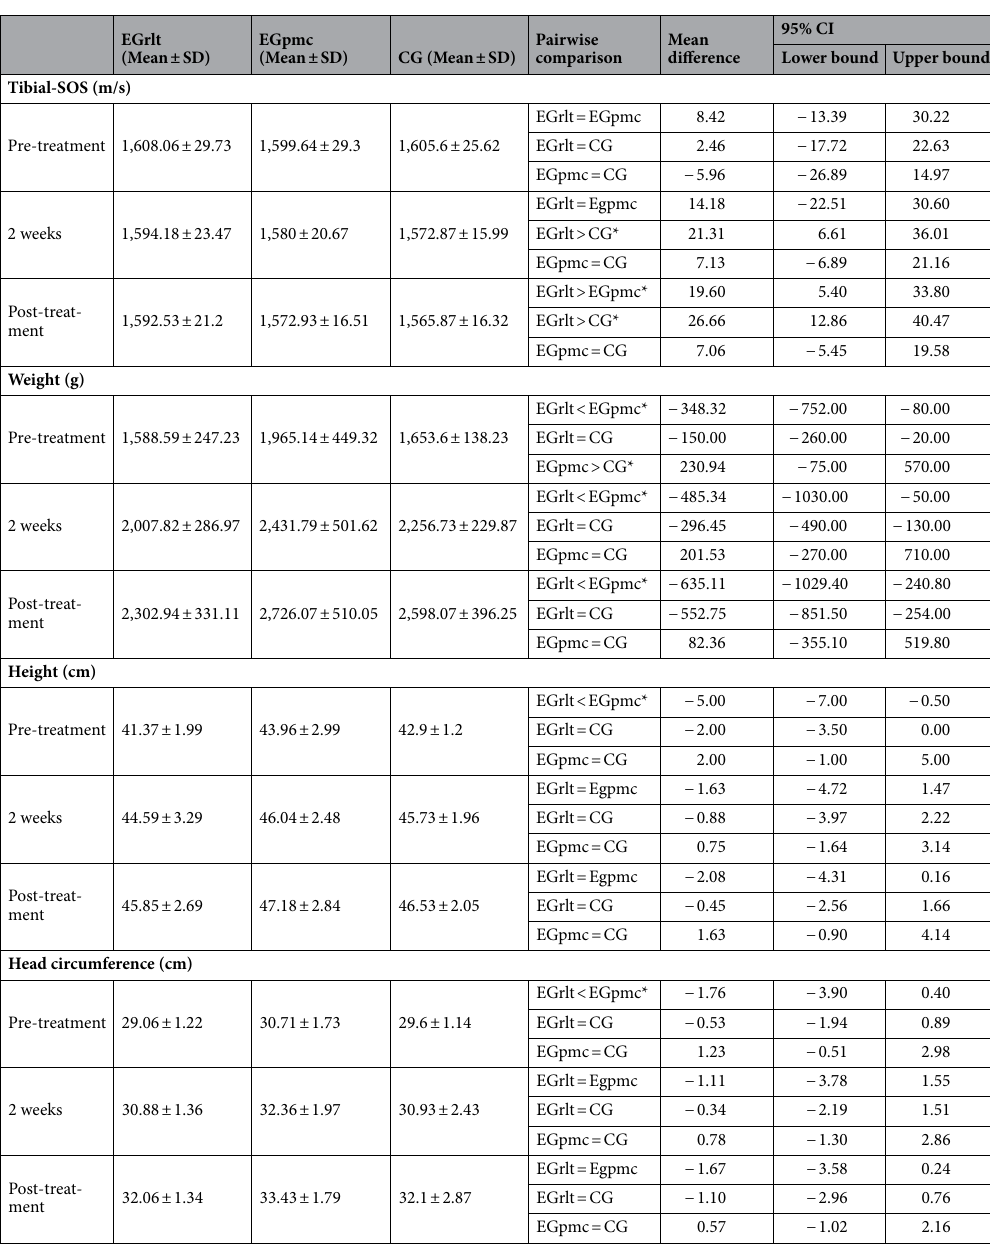
Table 2. Effect of the different interventions on the tibial speed of sound (m/s) and anthropometric measures during the study period. *p < 0.05 for differences among groups. CG = Control Group. EGpmc = Experimental group treated with passive movements with gentle compression. EGrlt = Experimental group treated with reflex locomotion therapy. 95% CI = 95% Confidence Interval. Data are presented as means ±